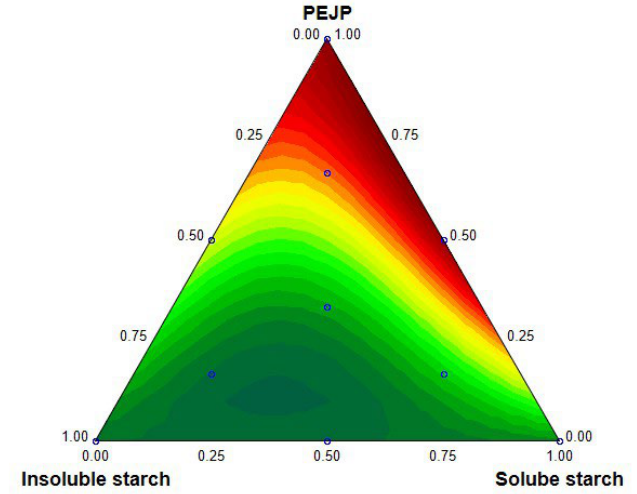
Figure 2. Two-dimensional response surface plot depicting the effect of the variables (SS, IS, and PEJP) on the antioxidant potential of the starch-PEJP films.